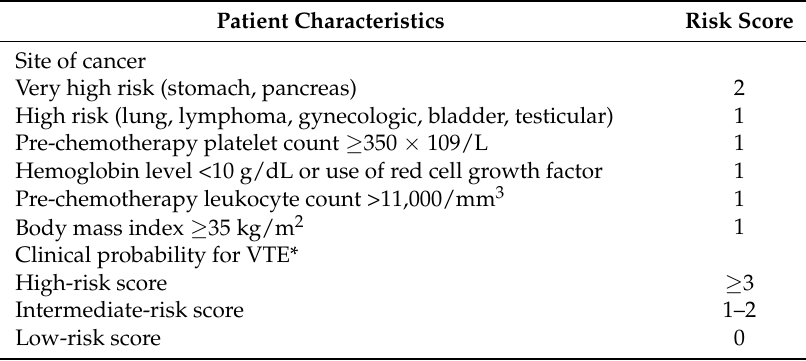
Table 1. Predictive model for venous thromboembolism